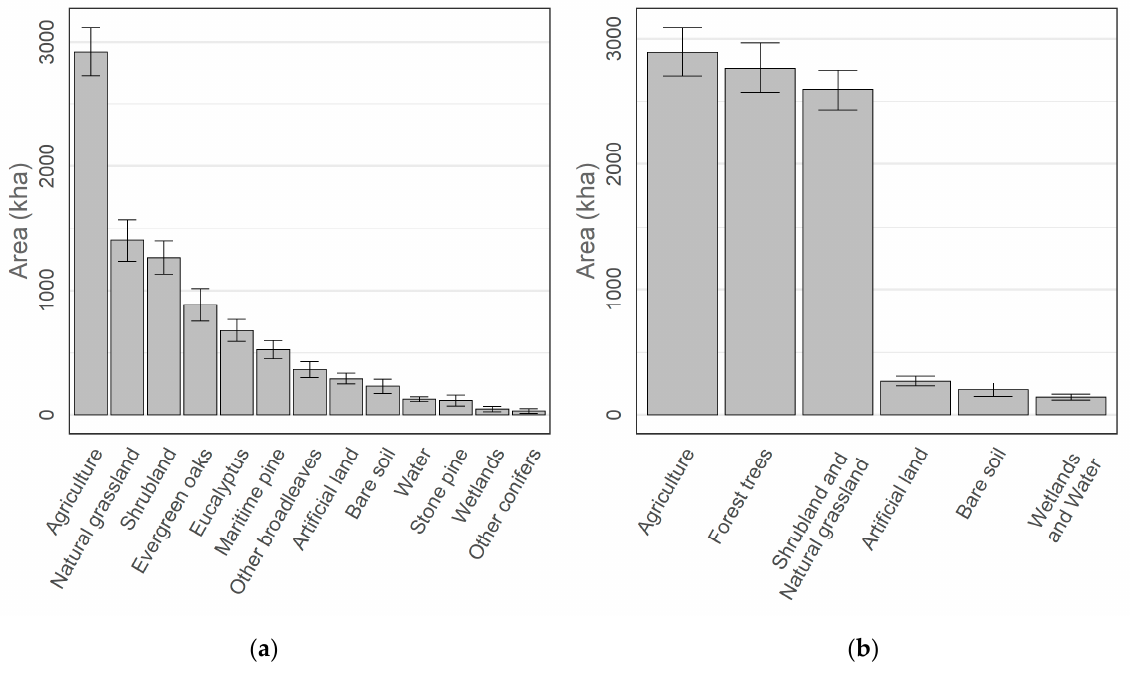
Figure 6. Estimated area occupied by the land cover classes: ( a ) 13 classes (level 3), ( b ) 6 classes (level 1). These estimates provide new insights on land cover of mainland Portugal. For